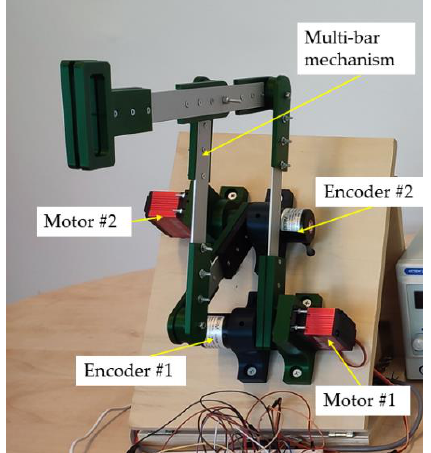
Figure 13. The construction and structure of the haptic mechanism. Because the gearmotors do not have a control of the rotation angle, encoders (rotation sensors of type OMRON E6B2-CWZ6C) with a measuring accuracy of 2500 pulses/rotation were